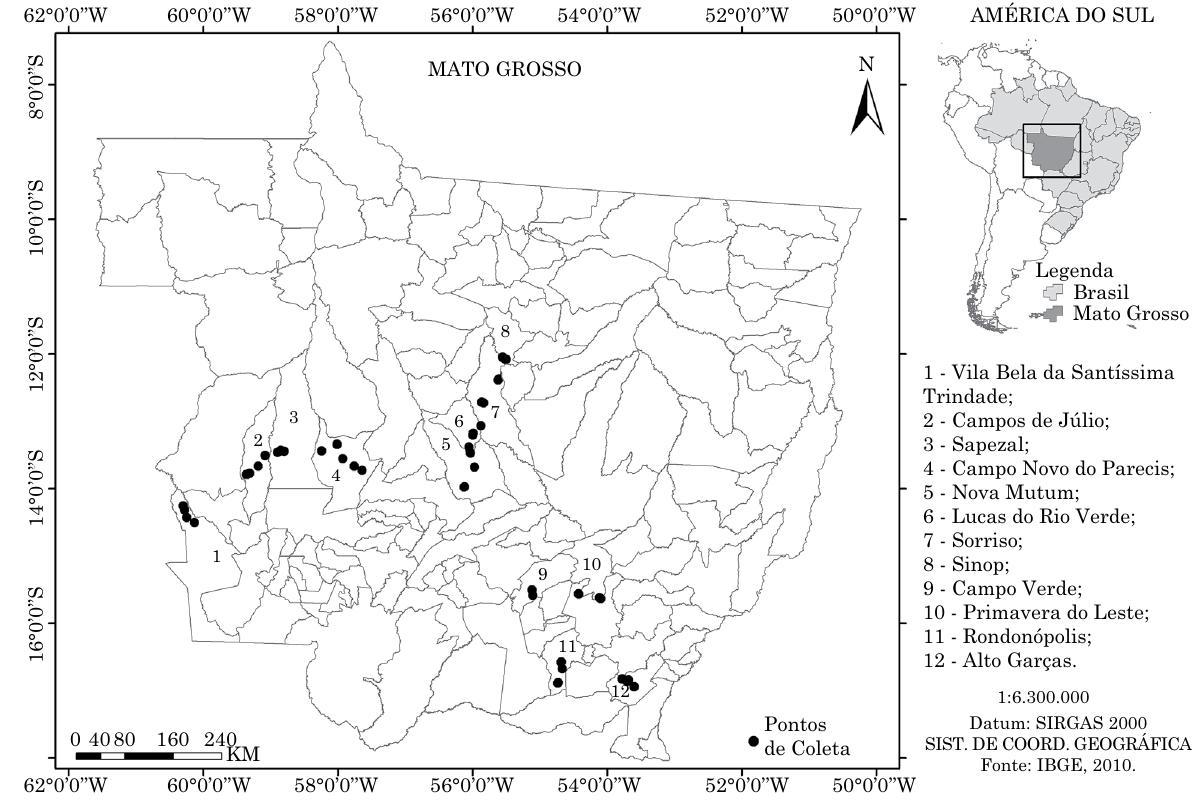
Figura 1. localização dos pontos de coleta das amostras de